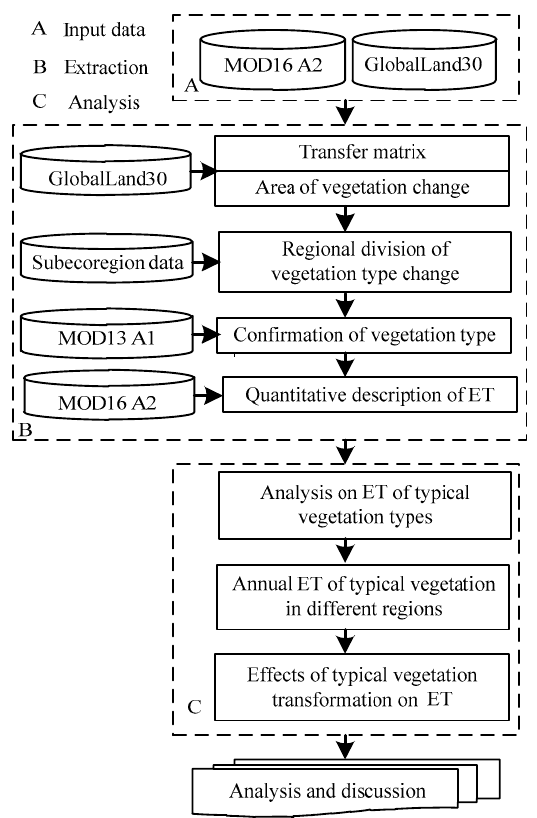
Figure 5. Flow-chart of information process.